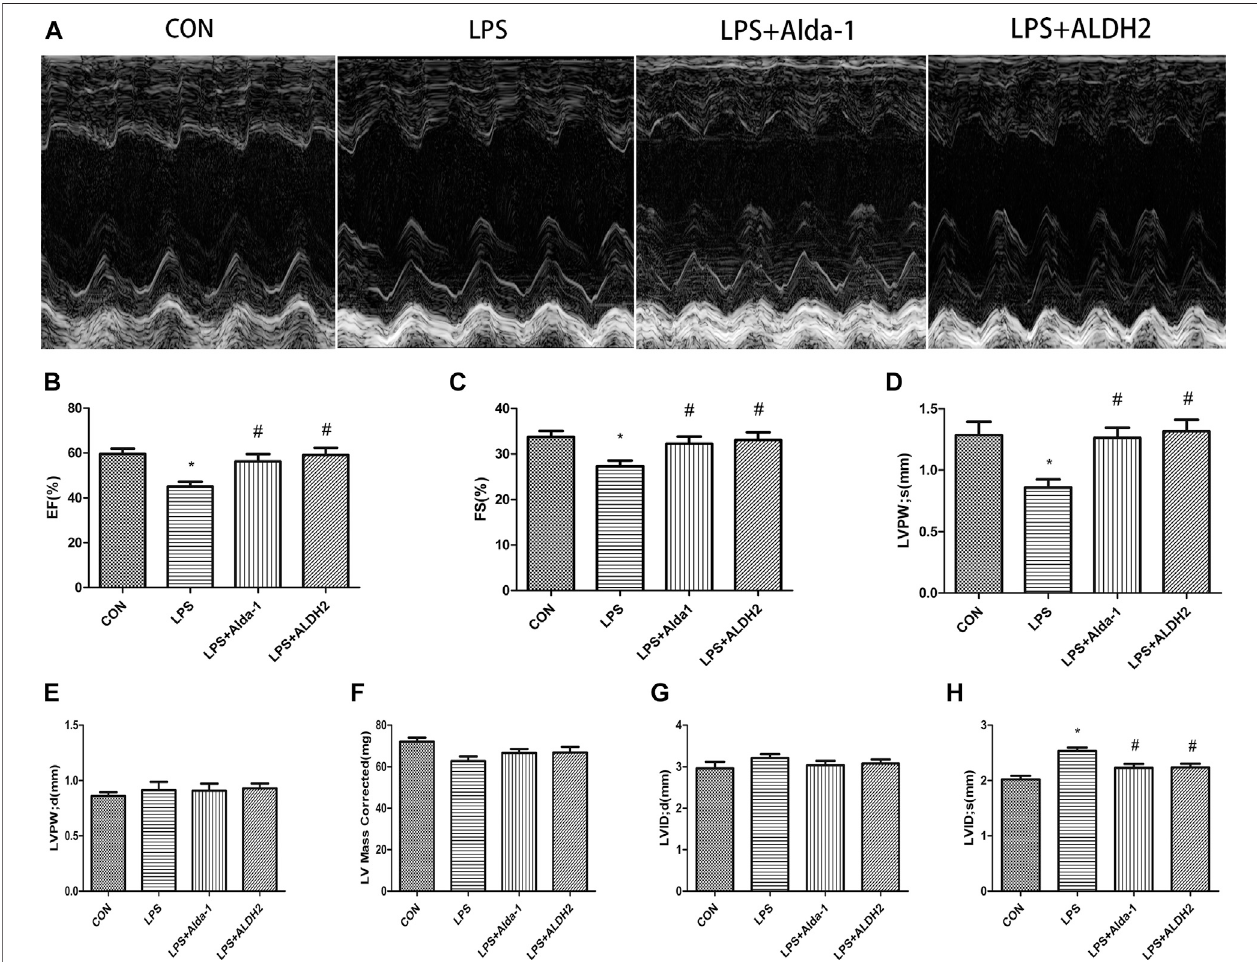
FIGURE1| Cardiacfunctioninlipopolysaccharide(LPS)-treatedmice. (A) Representativeechocardiographicimagesfromfourmousegroups. (B) Ejectionfraction (EF). (C) Fractional shortening (FS). (D) Leftventricularposteriorwallthicknessinsystole(LVPWs). (E) Leftventricularposteriorwallthicknessindiastole(LVPWd) (F) Left ventricular mass. (G) End-diastolic left ventricular internal diameter (LVIDd). (H) End-systolic left ventricular internal diameter (LVIDs). Data are the mean ± standard error of the mean. n (cid:1) 6 mice/group. Statistical analyses were performed by one-way analysis of variance, followed by Tukey ’ s post hoc test for multiple comparisons. * p < 0.05 vs. control (CON); # p < 0.05 vs.